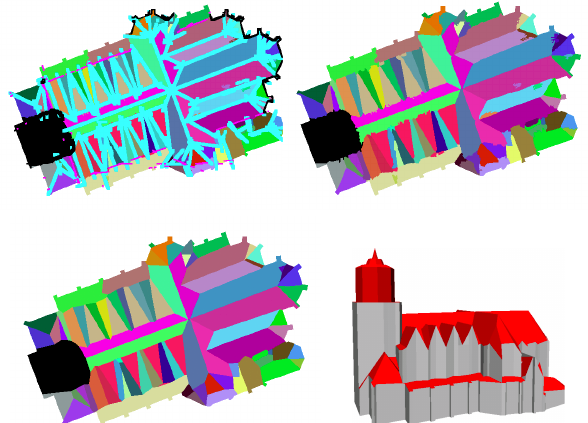
Figure 11: Processing for the market church in Figure 7 contin- ued: The upper left picture shows the ground plan, bold cyan intersection lines between planes and thin violet step lines (spire has been removed). The upper right picture displays the result of filling with respect to intersection lines and step edges. The lower left figure shows the outcome of polygon detection and simplifi- cation. Also, the final 3D model of the market church is shown.